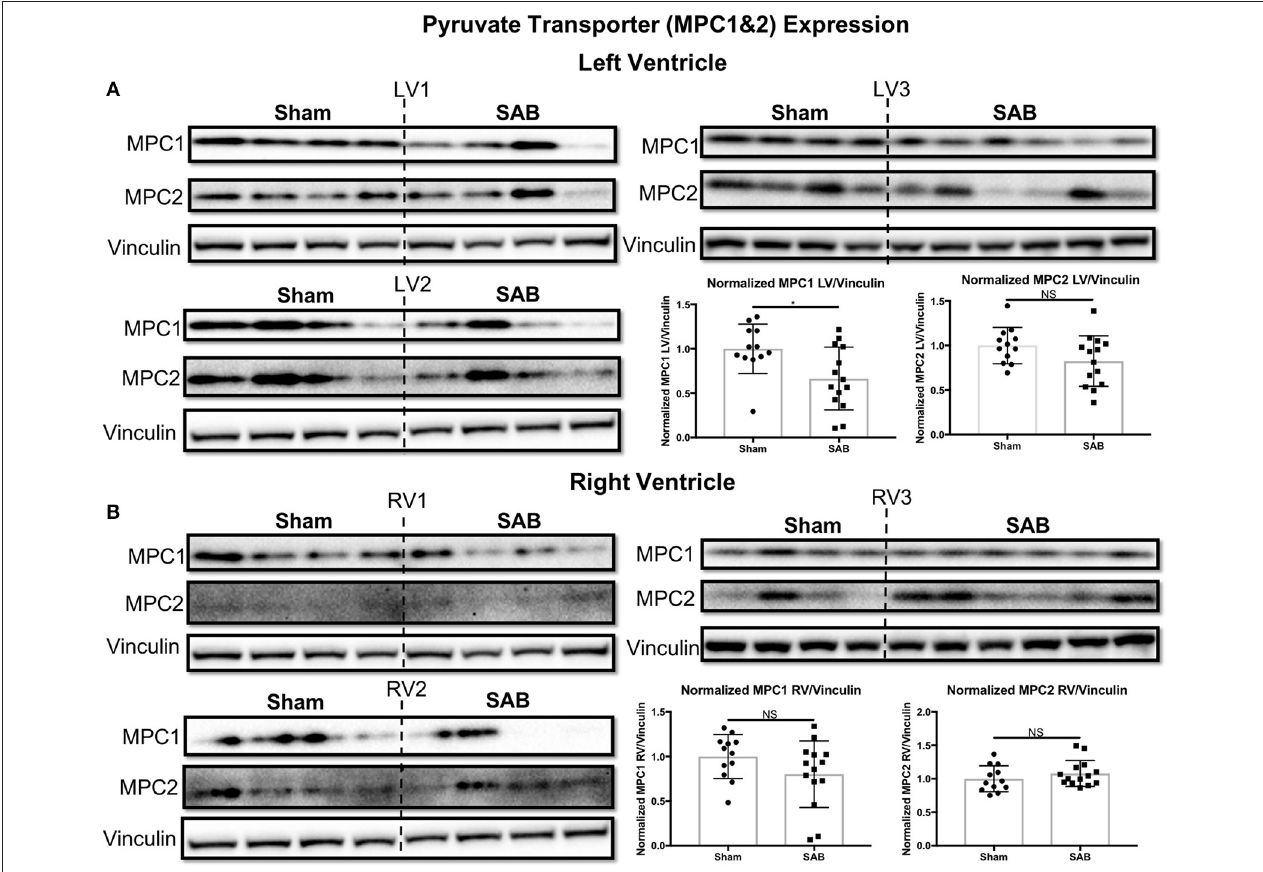
FIGURE 8 | Mitochondrial pyruvate carrier 1 (MPC1) is upregulated in supra-coronary aortic banding (SAB) vs. sham rats. (A) Western blot showing significant upregulation of MPC1, but no change in MPC2 level in the left ventricle (LV) of SAB vs. sham rats. (B) Western blot showing no significant change of MPC 1&2 expression in the right ventricle (RV) of SAB vs. sham rats. Each band represents a unique animal. Three experimental cohorts are done; hence three groups are shown, labeled as 1–3. The same vinculin loading control is used for proteins probed on the same